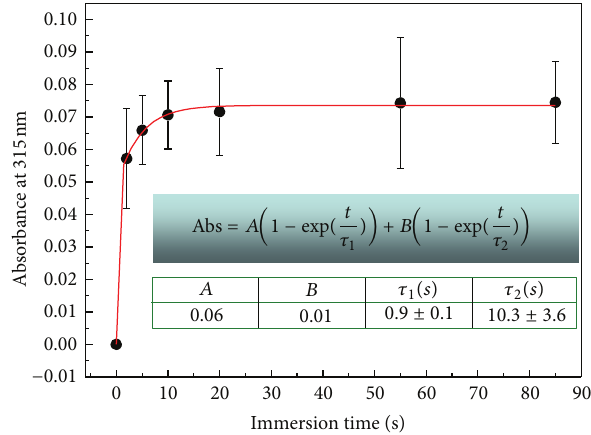
Figure 2: Growth kinetics followed by absorbance at 315 nm versus immersion time for a SinA